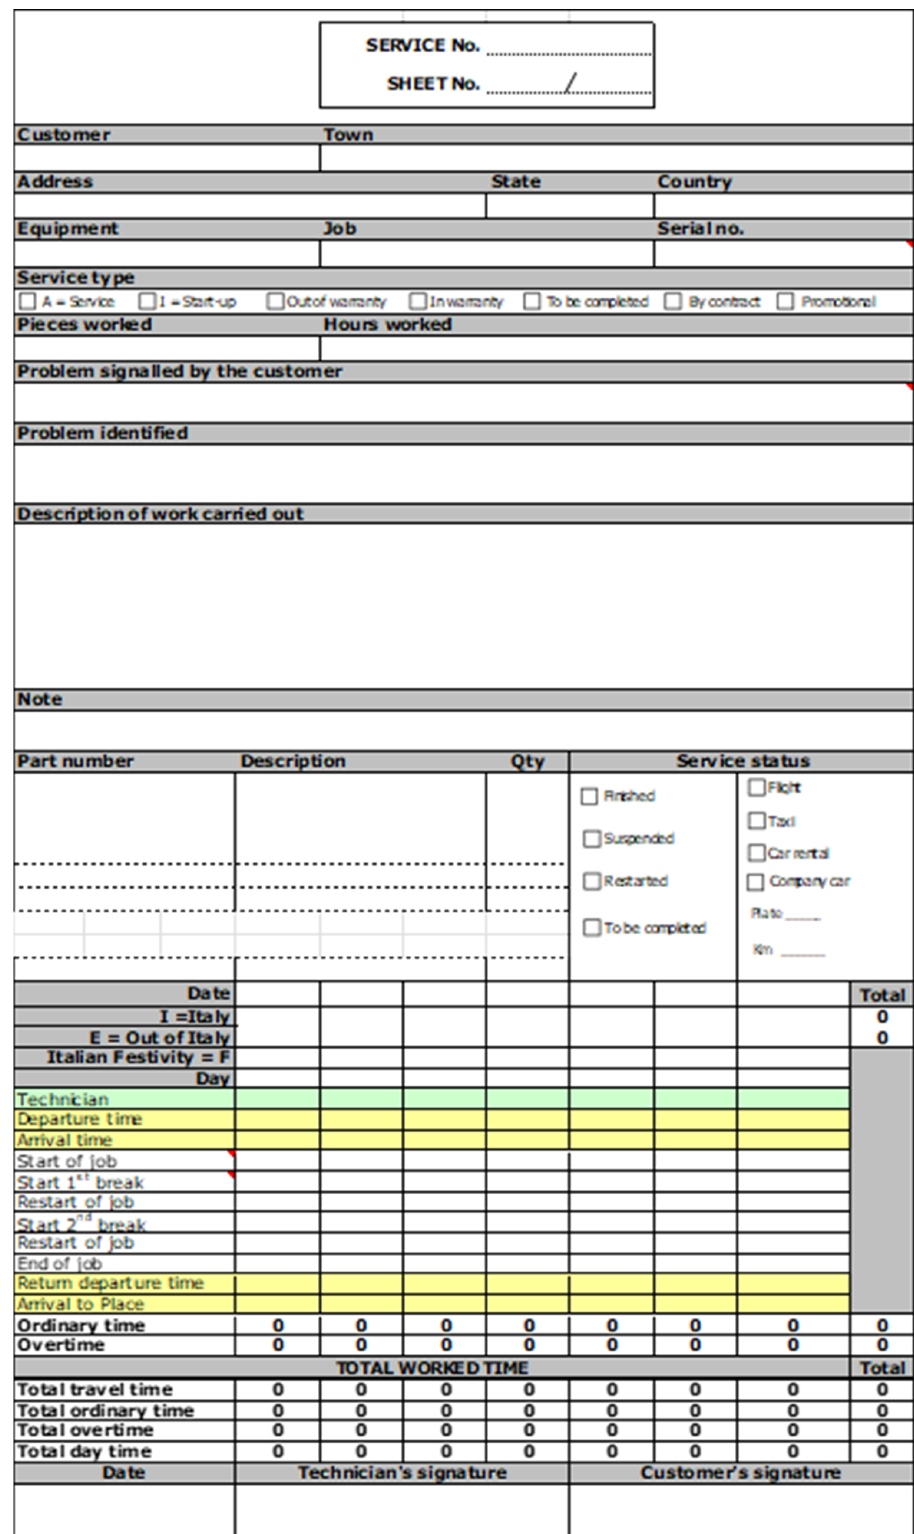
Figure 2. The original Service Report. The figure is elaborated by the authors.